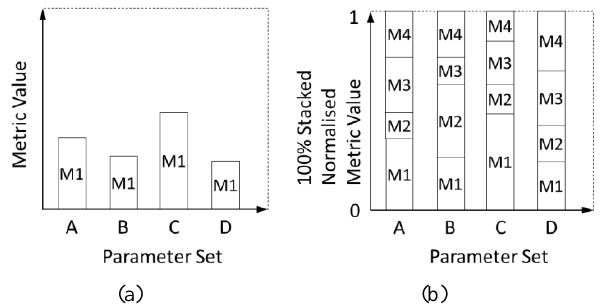
Figure 6 Metric spectrum. (a) A single metric value for multiple parameter sets A, B, C and D. (b) Metric spectrum as 100% stacked normalised metric sets.